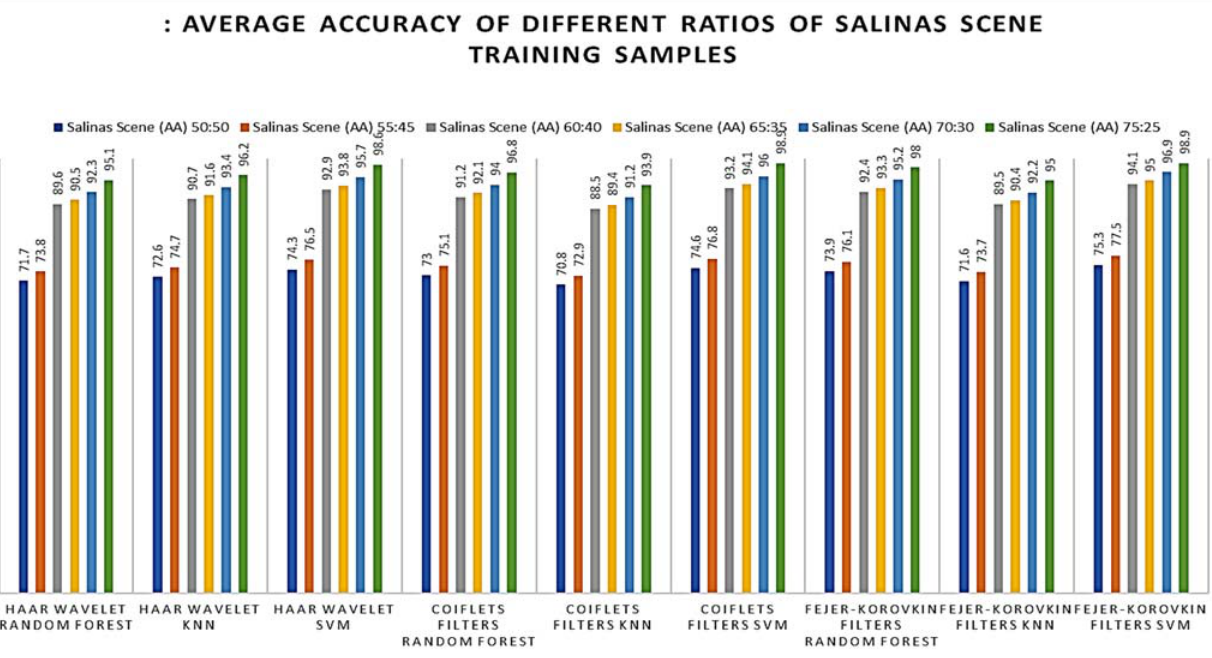
Figure 13. Average accuracy of different ratios of Salinas Scene training samples (plot of different types of training and testing samples).